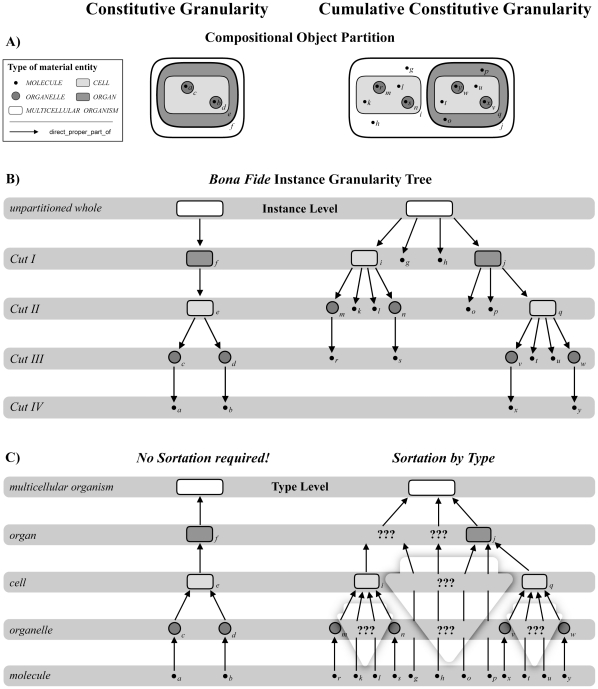
Trans-Granular Multiple Instantiation and the Distinction of Instance Granularity and Type Granularity.A) Left: Compositional partitions of a constitutively organized idealized multicellular organism into its constitutive object parts. Four partitions are shown: (i) into organs (f); (ii) into organ cells (e); (iii) into organelles (c,d) of organ cells; and (iv) into organelle molecules (a,b). Right: Compositional partitions of a cumulative-constitutively organized idealized multicellular organism into its constitutive object parts. The same corresponding four partitions are shown: (i) into organs (j) alongside with cells (i) and extracellular molecules (g,h), both of which are not part of any organ; (ii) into organ cells (q) and extracellular molecules (o,p) that are part of some organ, organelles (m,n) that are part of cells which are not part of any organ, and cellular molecules (k,l) that are neither part of any organ nor any organelle; (iii) into organelles (v,w) of organ cells and molecules (t,u) that are part of these organ cells but not part of any organelle, as well as molecules (r,s) of organelles of cells which are not part of any organ; and (iv) into organelle molecules (x,y) that are part of organ cells. B) Left: The instance granularity tree of constitutively organized bona fide objects based on the corresponding four partitions. Each partition constitutes a cut in the instance granularity tree (Cut I–IV) and thus an instance granularity level. Contrary to cumulative-constitutively organized material entities, particular instances of the same type of material entity do not belong to different cuts and thus are restricted to a single level of instance granularity. The types' extensions do not transcend the boundaries between instance granularity levels. Right: The instance granularity tree of cumulative-constitutively organized bona fide objects based on the corresponding four partitions. Particular instances of the same type of material entity, like for instance of the type MOLECULE, belong to different cuts and thus different levels of the respective instance granularity. In other words, the extension of the type MOLECULE transcends the boundaries between instance granularity levels. C) Left: The constitutive instance granularity tree that results from the corresponding four partitions can be directly transformed into the respective type granularity tree – no sortation required since they are topologically identical. Right: The cumulative constitutive instance granularity tree that results from the corresponding four partitions cannot be directly transformed into or mapped upon the respective type granularity tree. However, by (i) following the simple and intuitive rule of sortation-by-type (i.e. a type occupies the same granularity level as its finest grained instance) and by (ii) applying a more complicated granularity scheme (Vogt 2010), one can infer a type granularity tree. Unfortunately, this results in types of entities belonging to type granularity levels for which BFO provides no respective categories as templates for granularity specific ontologies (here marked ‘???’). For instance when looking at the cellular level, a cellular ontology that is based on BFO provides no category for molecules that are not part of any cell, since they are neither a cell (i.e. BFO's ‘object’), nor a cell aggregate (i.e. BFO's ‘object aggregate’) or fiat cell part (i.e. BFO's ‘fiat object part’), nor any of the additional categories of the extended BFO. (modified from [19]).